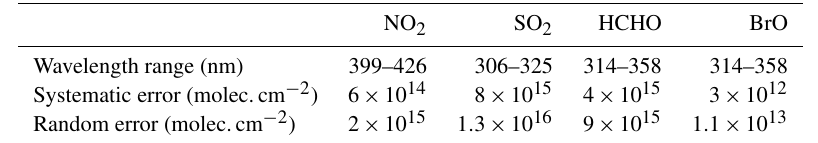
Table 1. Overview on the different fitting ranges and systematic and random errors for the retrieved trace gas dSCDs (for spectra averaged from 10 original spectra). More details are found in the Supplement.